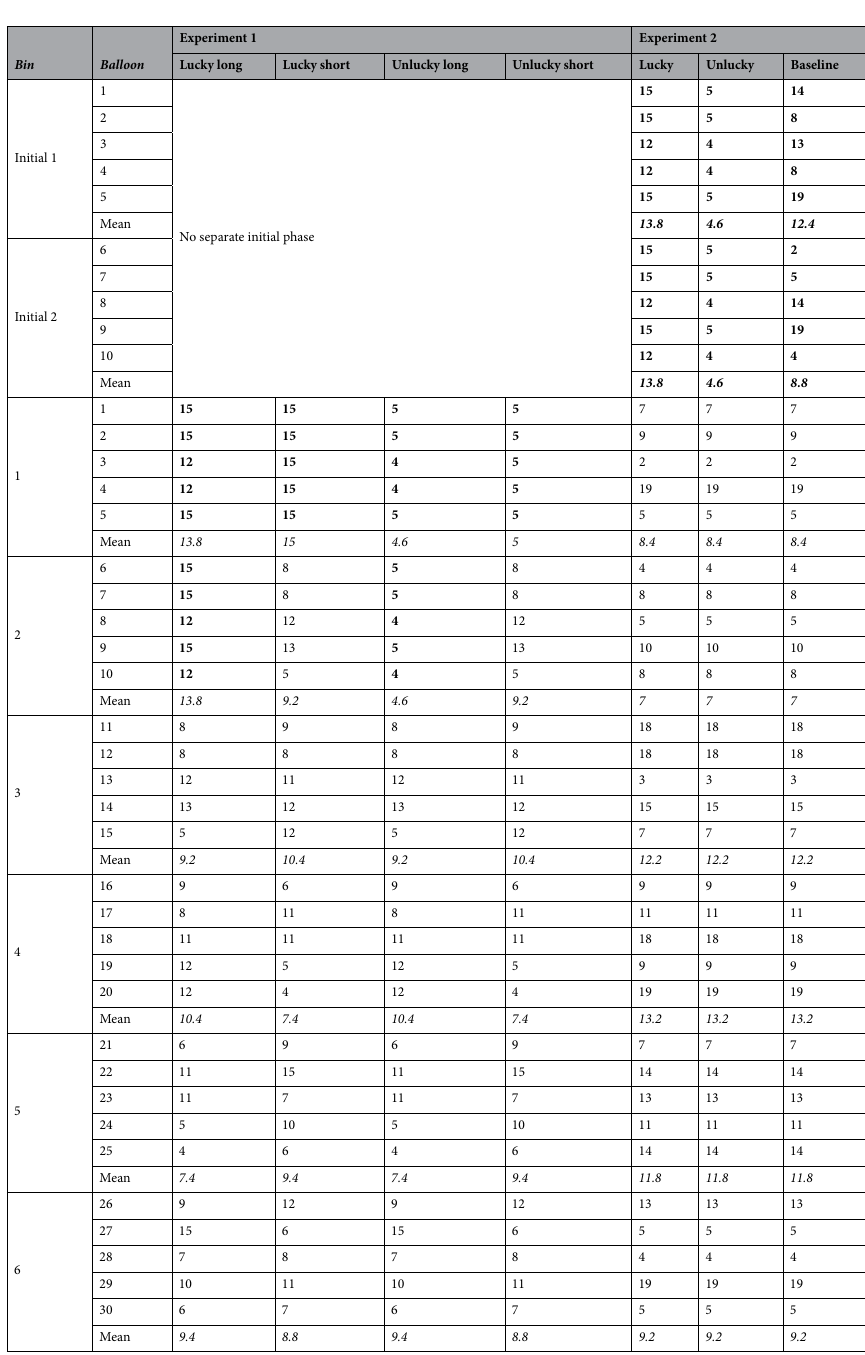
Table 2. Maximum number of successful pumps (balloon tolerance) for each balloon in each condition in Experiments 1–2. Values presented in the table were the same across participants. Initial phases during which we controlled for lucky, unlucky, or baseline experience are bold faced. In Experiment 1, the initial phase was part of the main task including altogether 30 balloons; in Experiment 2, the initial phase included ten separate balloons that were followed by the subsequent phase with 30 balloons. Horizontal lines denote separate time bins, each consisting of five consecutive balloons. Experiment 1 consisted of six bins; Experiment 2 consisted of altogether eight bins, two bins in the initial phase and six bins in the subsequent phase. Numbers in the column labelled as “Bin” denote the sequential numbers of time bins; those in the column labelled as “Balloon” denote the sequential numbers of balloons. Maximum number of successful pumps means that if a participant inflated the given balloon one pump further, the balloon burst (i.e., balloon tolerance). Mean tolerance values are provided below each bin in italics . Note that the remainder sequence of balloons was the same between lucky long and unlucky long conditions, and between lucky short and unlucky short conditions in Experiment 1. In addition, the first 20 balloons in the remainder sequence of all conditions were the same in Experiment 1. In Experiment 2, the subsequent phase was the same across all